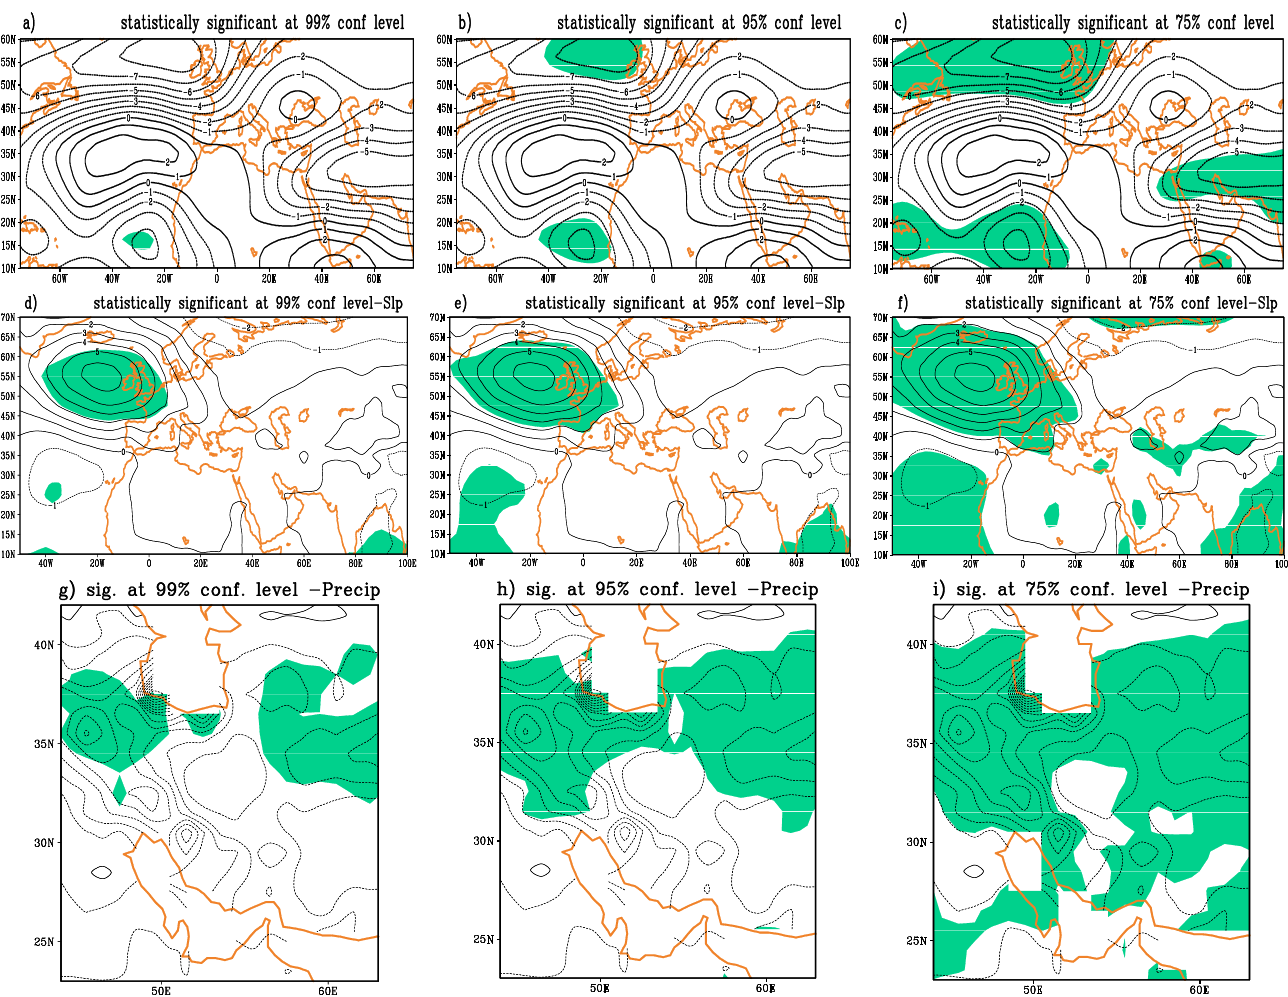
Figure 9. Distribution of statistically significant WAF ( a – c ). SLP ( d – f ) and autumn precipitation anomaly ( g – i ) at different confidence levels. Table 6. Areas of statistically significant differences in precipitation at different confidence levels.